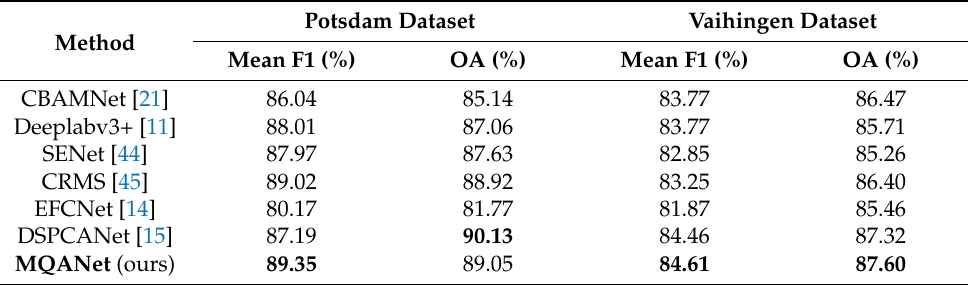
Table 9. Quantitative results of the current